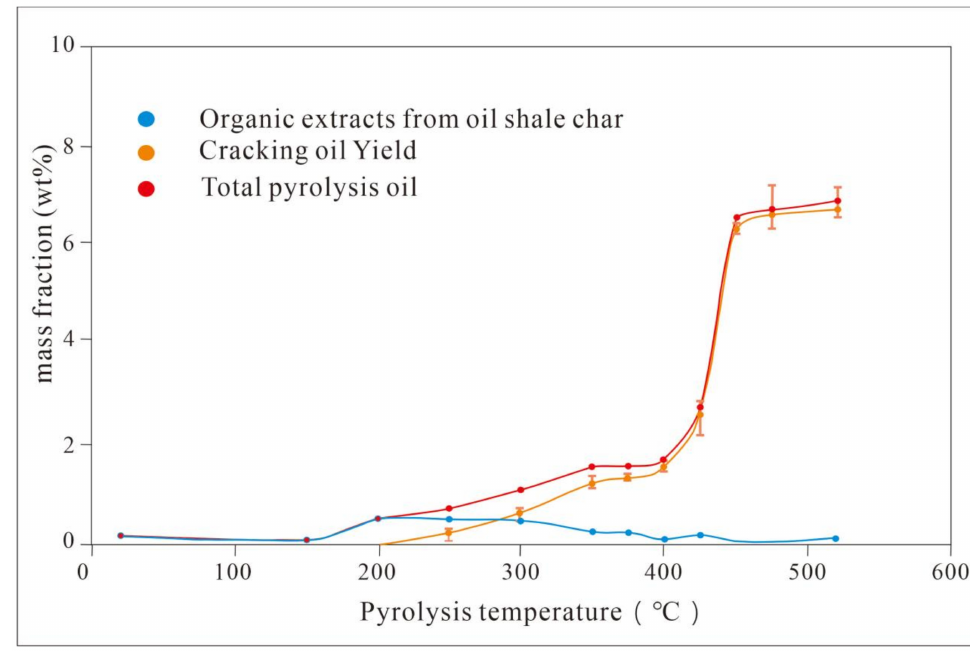
Figure 5. Nongan pyrolysis oil yield. Table 1. Results of pyrolysis products at different temperatures.